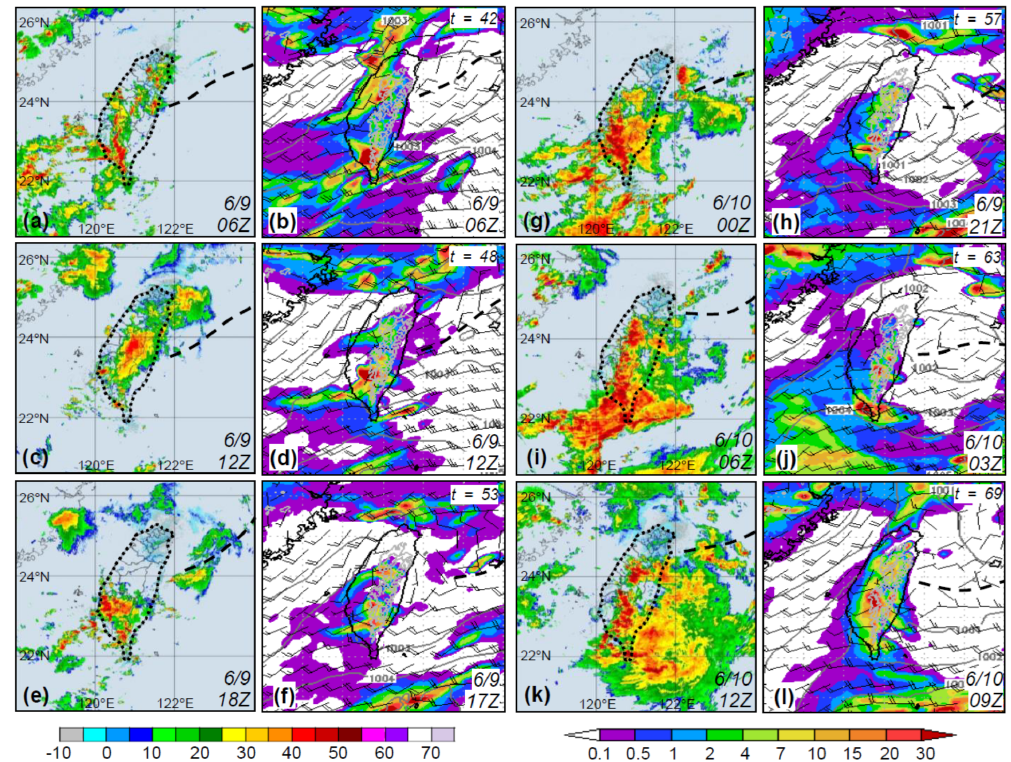
Figure 8. (a, c, e, g, i, k) Radar reflectivity composite (dBZ; scale at bottom left) in the Taiwan area (width roughly 600km) every 6h from (a) 06:00UTC 9 June to (k) 12:00UTC 10 June 2012 (original plots provided by the CWB). (b, d, f, h, j, l) The CReSS forecast, starting from 12:00UTC 7 June 2012, of sea-level pressure (hPa; every 1hPa, over ocean only), surface wind (kn; barbs, at 10m), terrain height at 1 and 2km (gray contours), and hourly rainfall (mm; color, scale at bottom right) valid at the time or within 3h of the radar composite as labeled – in UTC (forecast time in h) in lower (upper) right corner – over the same area. The thick dashed lines mark the position of surface frontal or wind-shift line, based on NCEP gridded analyses for the observation (outline of Taiwan also highlighted).